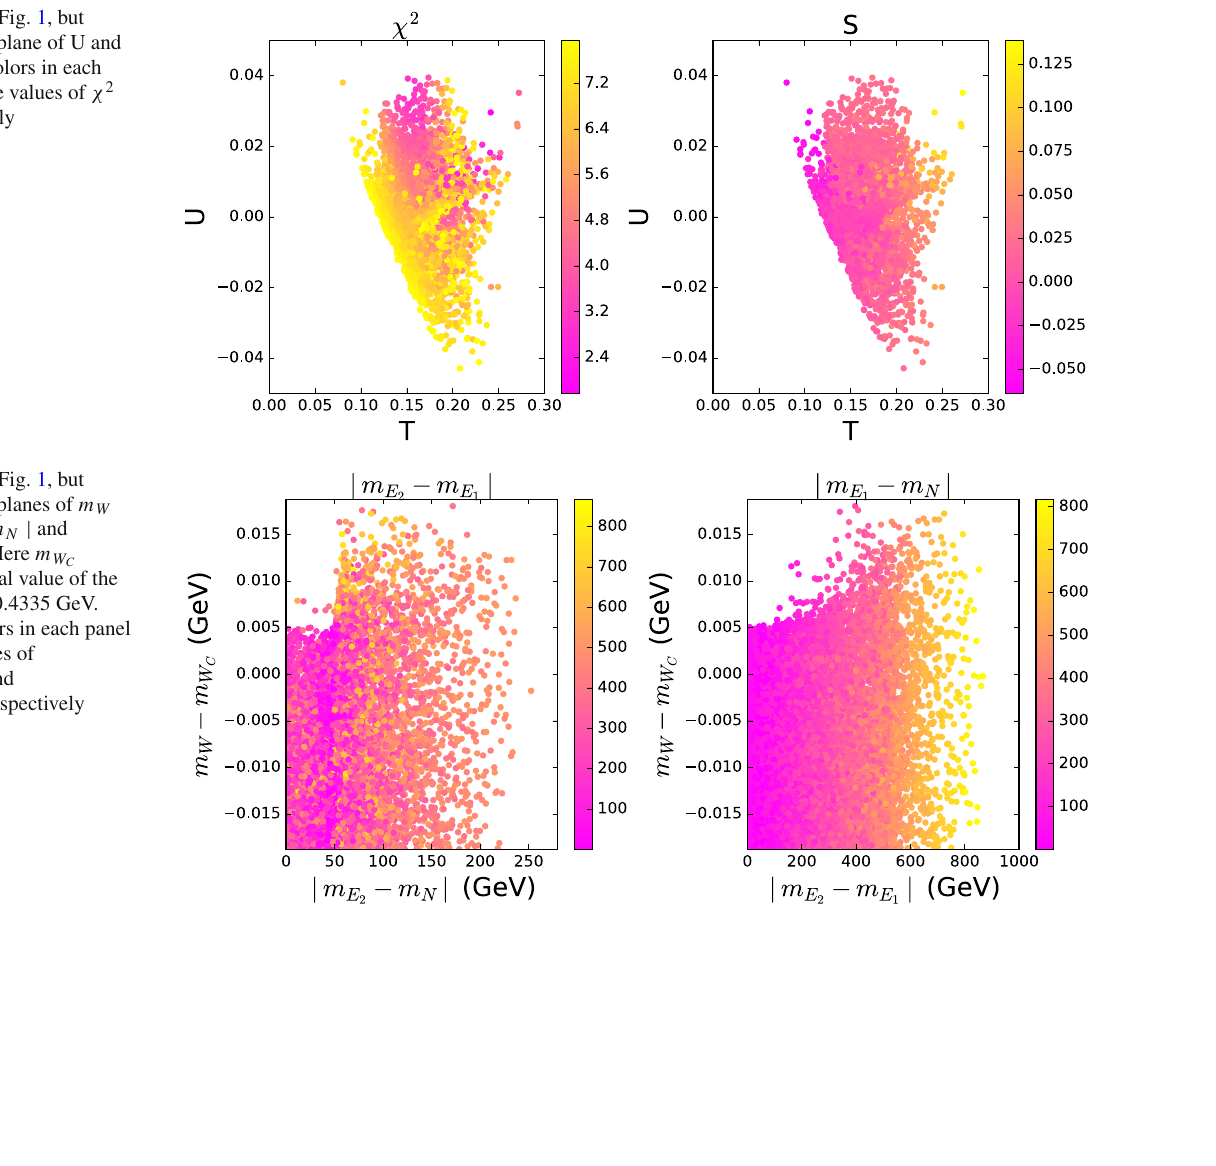
− m | and | m − m | , respectively N E 2 E 1 1